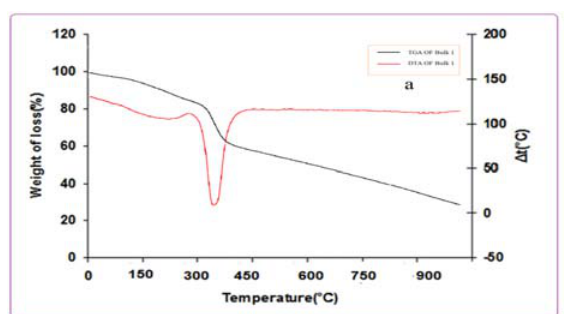
Fig. 5. TGA and DTA diagrams of compound 1. Figure 2-c attributed to the XRD pattern of the residue obtained from calcination of compound 1 nano- structures at 673 K. SEM image (Figure 6) of the residue obtained from calcination of compound 1 nano-structure at 823 K shows that O with the diameter about 51 nanoparticles of Co 3 4 nm.